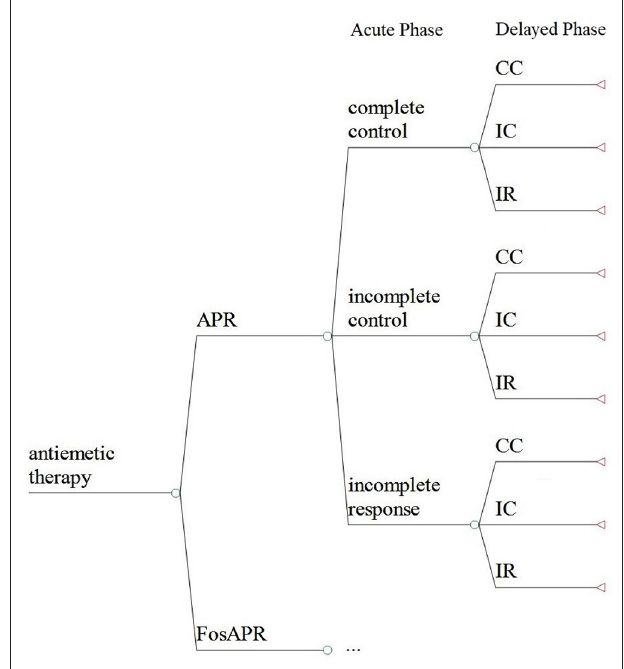
FIGURE 1 | The decision model of the cost-effectiveness analysis. FosAPR, fosaprepitant; APR, aprepitant; CC, complete control; IC, incomplete control; IR, incomplete